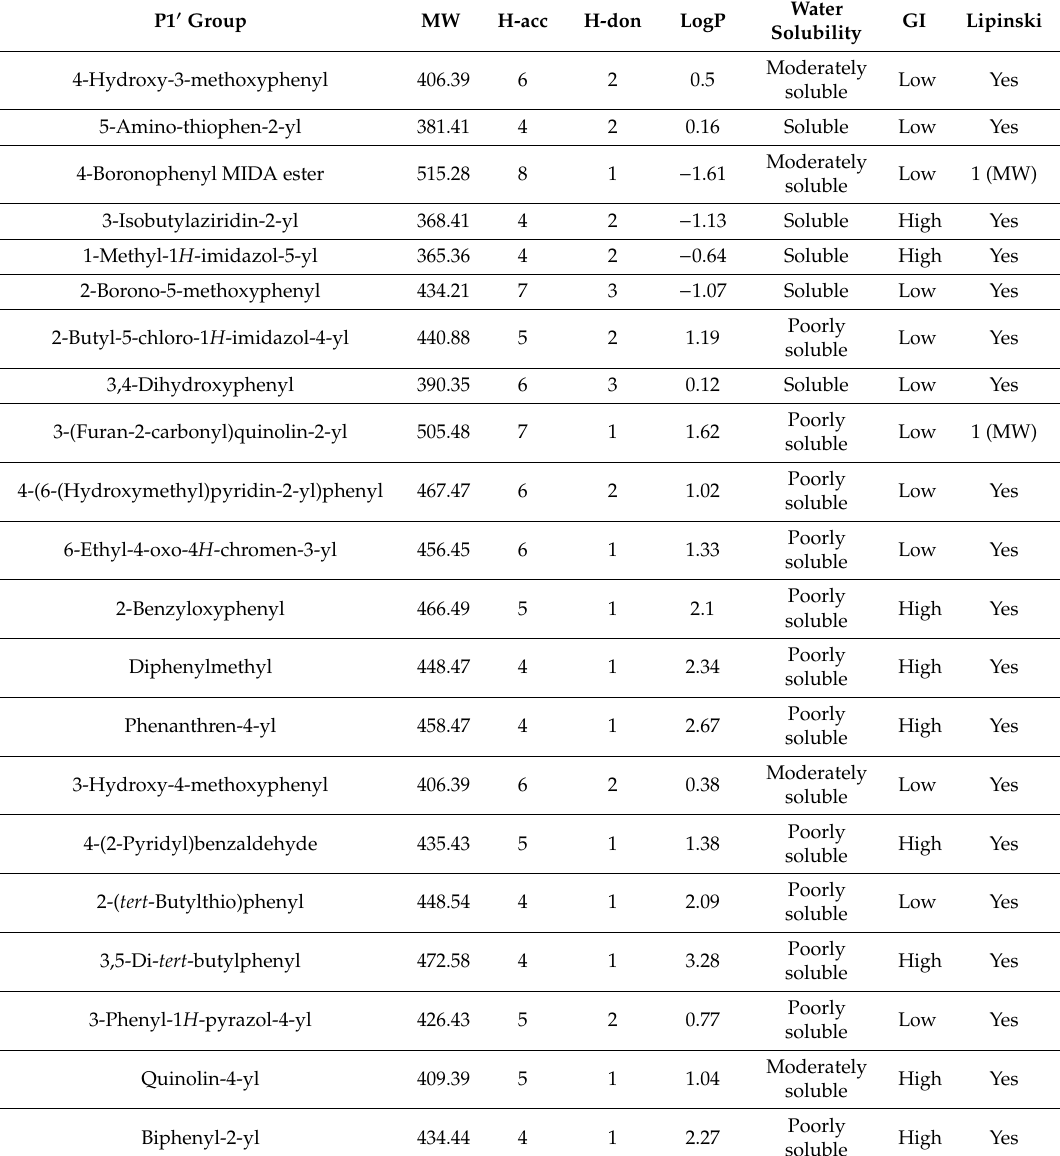
Table 8. Selected ADMET properties for M1 predicted inhibitors: MW, molecular weight; H-acc, H-bond acceptor number; H-don, H-bond donor number; LogP, logarithm of partition coe ffi cient; GI, gastrointestinal absorption; Lipinski, fulfilling the rule of five; otherwise, the exceptions are given in